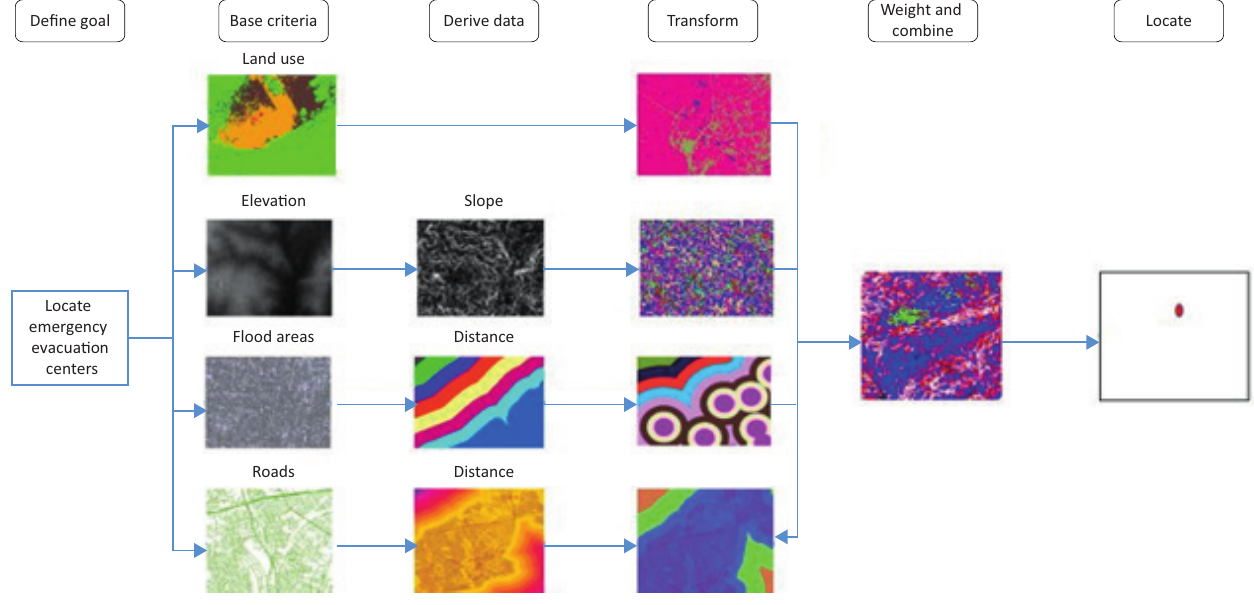
FIGURE 3: Workflow of data